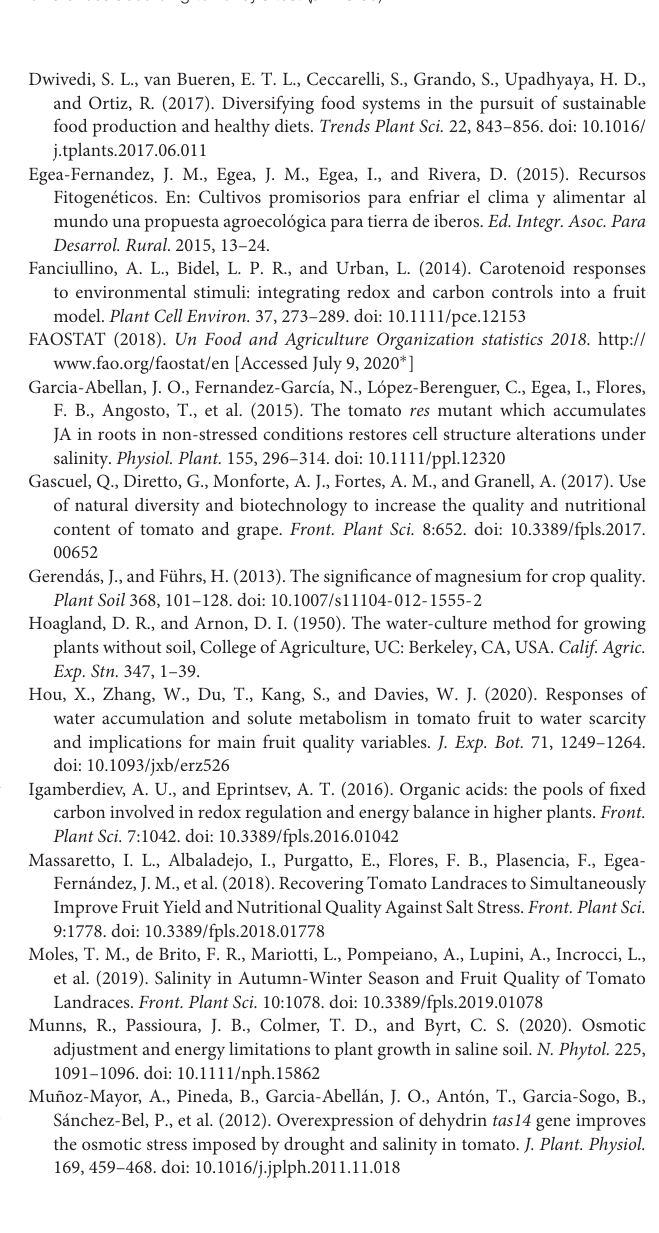
and leaf number) and leaf chlorophyll content and fluorescence just before starting the salt treatment (50 mM NaCl). Values are expressed as means ± SE of 14 plants per genotype. Different letters indicate statistically significant differences according to Tukey’s test ( p < 0.05). Supplementary Table 1 | Water percentage and cation contents (mg g − 1 DW) in mature green and red ripe fruits of “Moneymaker” and two traditional varieties, “Tomate Pimiento” and “Muchamiel Aperado,” from plants grown in control and salt (50 mM NaCl). Three biological replicates of 10 fruits each were used. Values are expressed as means ± SE. Different letters indicate statistically significant differences according to Tukey’s test ( p < 0.05). Supplementary Table 2 | Carotenoids and chlorophylls contents ( µ g g − 1 DW) in mature green and red ripe fruits of “Moneymaker” and two traditional varieties, “Tomate Pimiento” and “Muchamiel Aperado,” from plants grown in control and salt (50 mM NaCl). Three biological replicates of 10 fruits each were used. Values are expressed as means ± SE. Different letters indicate statistically significant differences according to Tukey’s test ( p <